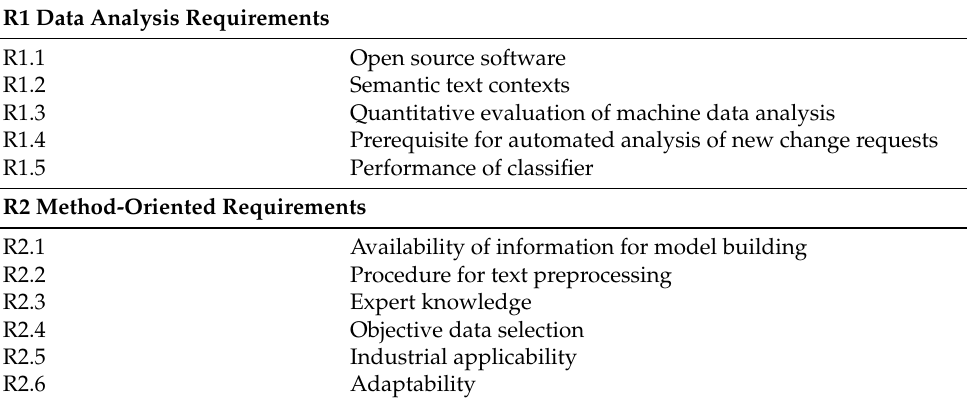
Table 1. Overview of